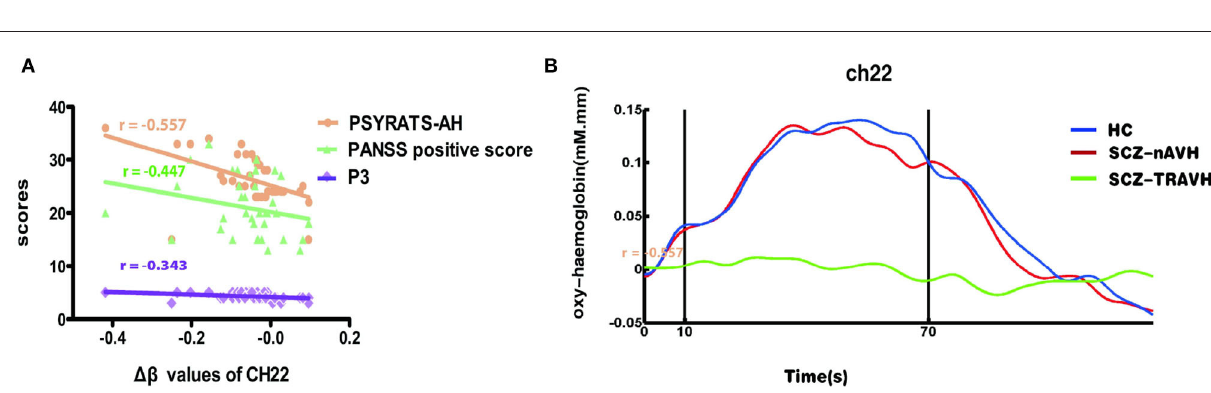
FIGURE 3 | (A) The 1 β values of oxy-hemoglobin were significantly associated with severity of hallucinations on the channel 22, including PSYRATS-AH, PANSS-positive score, and P3 score. (B) Average oxy-hemoglobin waveforms of three groups at the cortical regions. Vertical lines demarcate the start and end of the VFT task